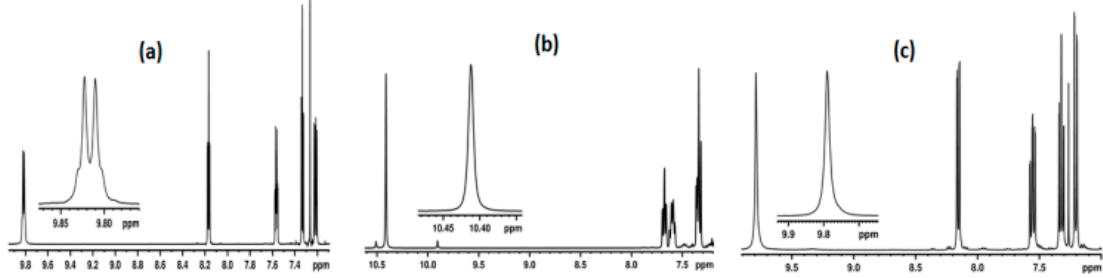
Figure 16. 400 MHz 1 H-NMR spectrum of molecule 9 , ( a ) in CDCl 3 ; ( b ) 1 H-NMR spectrum in DMSO- d 6 and ( c ) 1 H{ 19 F} NMR spectrum in CDCl 3 .